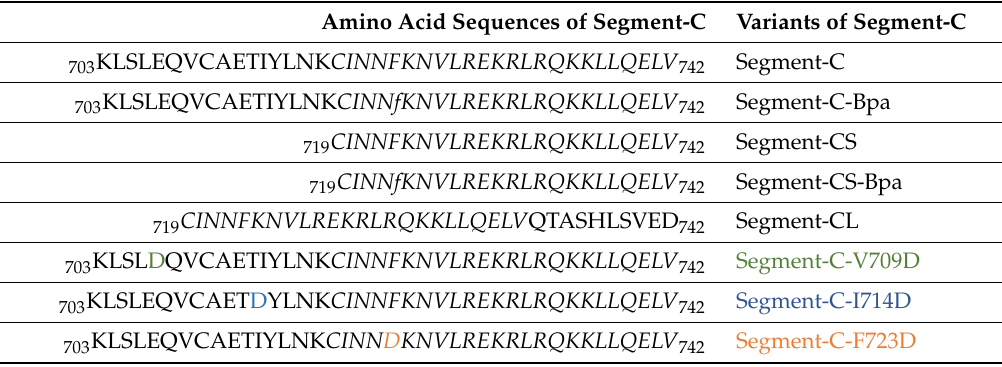
Table 3. Amino acid sequences of segment-C variants. Summary of segment-C variants employed in the experiments shown in Figures 5 and 6. The replacement by aspartate is colour-coded in the respective variants: green for V709D, blue for I714D, orange for F723D. The canonical CaM binding region [28] is shown in italics; f denotes Bpa.